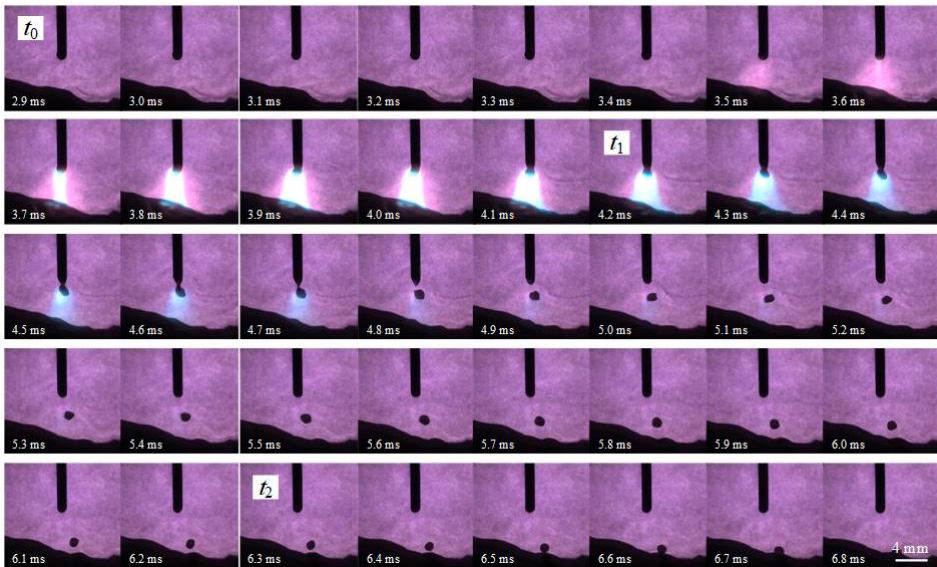
Figure 2. Main parameters of pulse current waveform.